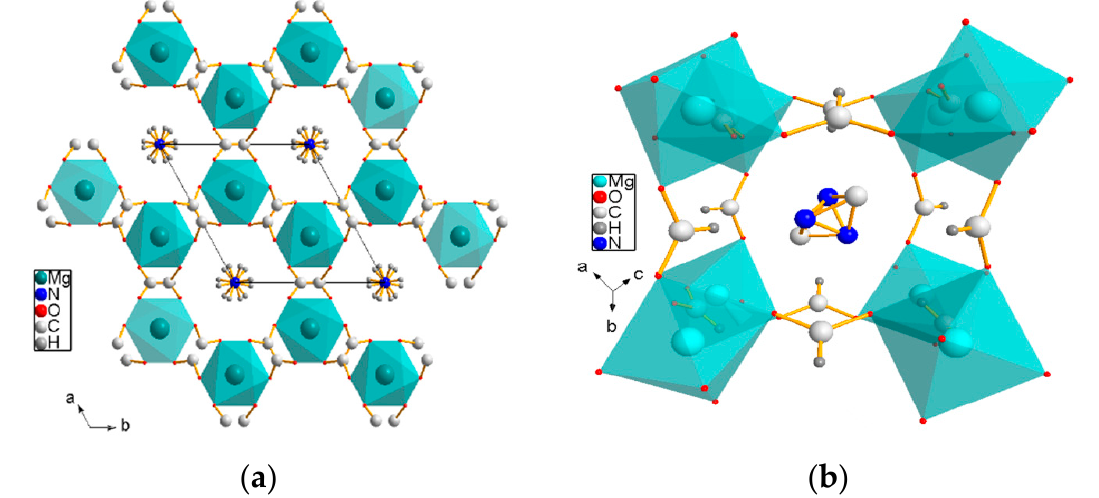
Figure 4. Structures of ( a ) [NH 4 ][Mg(HCOO) 3 ] and ( b ) [(CH 3 ) 2 NH 2 ][Mg(HCOO) 3 ] at room temperature.